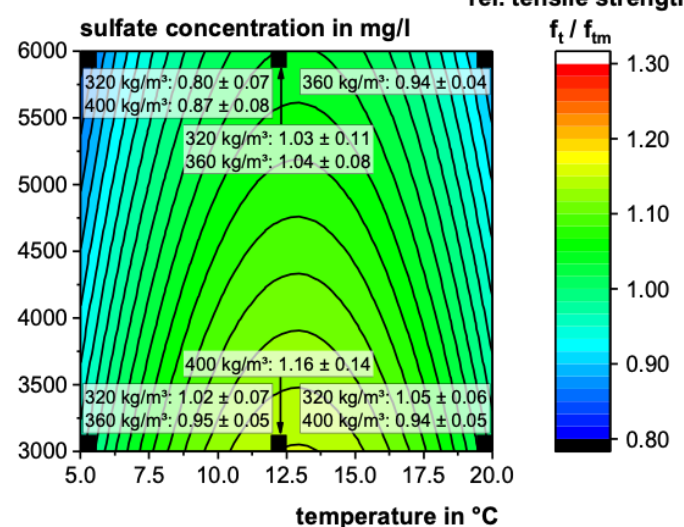
Figure 2. Contour diagram of relative tensile strength f t /f tm of concretes with (2) CEM I 42.5 after 182 days storage in Na 2 SO 4 solution, reference: fib maturation function.